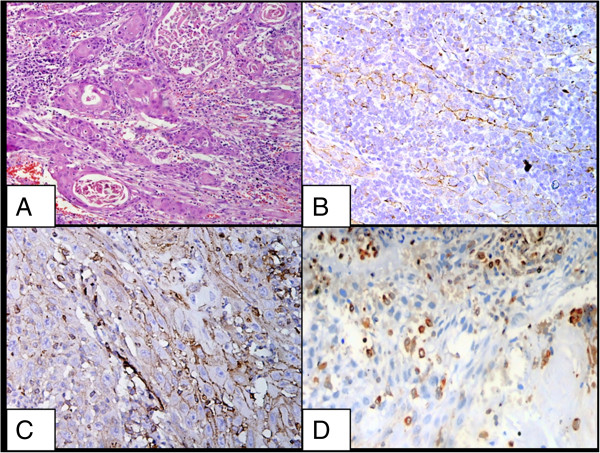
Staining pattern of squamous cell carcinoma. A. Squamous cell carcinoma, buccal mucosa, H&E X200; B. Low immunoreactivity of β-catenin in a case of squamous cell ]carcinoma X200; C. Low immunoreactivity of E-cadherin in a case of squamous cell carcinoma X200; D. Low immunoreactivity for vimentin in a case of squamous cell carcinoma X200.